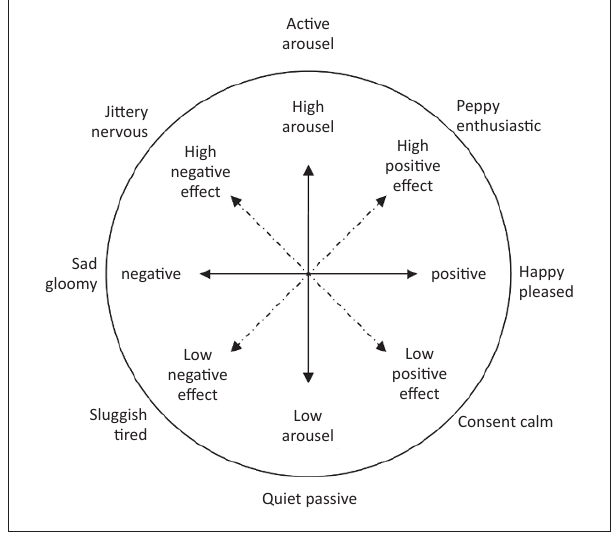
FIGURE 2 : Circumplex model of